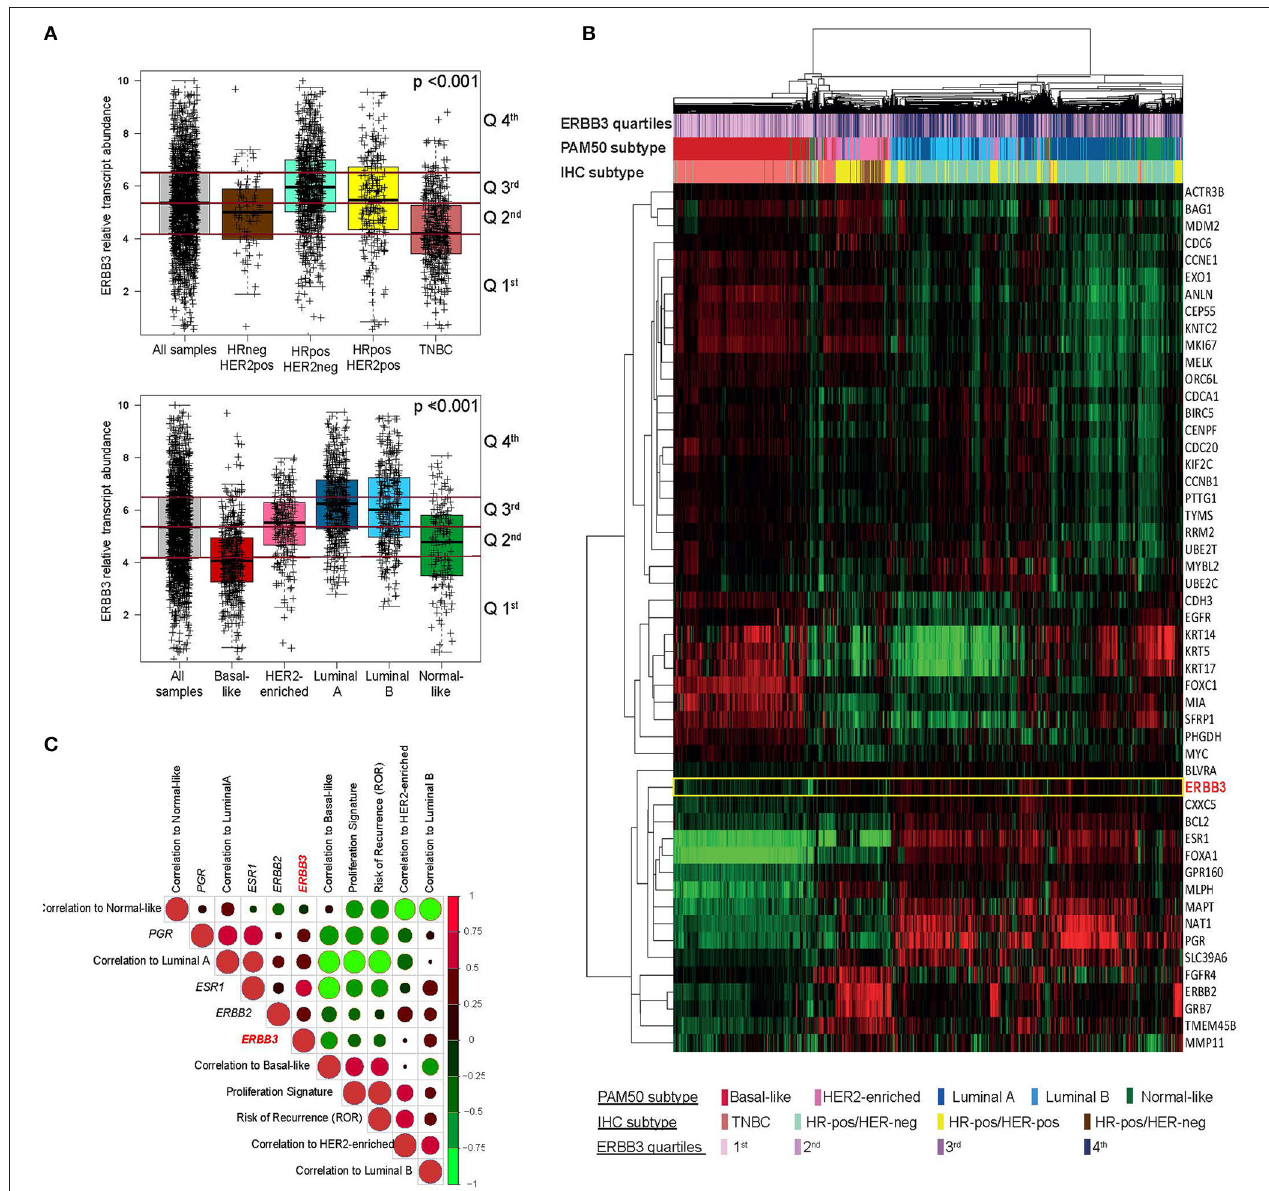
FIGURE 2 | Measurement of ERBB3 expression in breast cancer using the nCounter platform. (A) Box plots of ERBB3 gene expression in breast tumors as classified by hormone receptor and HER2 expression and intrinsic subtype. (B) Unsupervised hierarchical clustering using the 50 PAM50 genes and ERBB3 (rows) and 1,580 tumor samples (columns). Each colored square on the heatmap represents the relative median signature score for each sample with the highest expression being red, the lowest expression being green, and the average expression being black. (C) Pearson correlation between ERBB3 , single genes, and PAM50 gene expression signatures evaluated in breast cancer